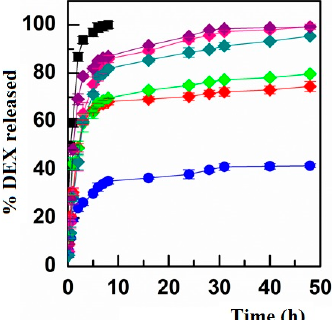
Figure 3. Drug release profiles: percentage of DEX released as a function of incubation time from INU-EDA-RA micelles (red), INU-EDA-RA-PEG micelles (green), INU-EDA-TAU-RA micelles (pink), INU-EDA-RA-CAR micelles (petrol green), and INU-EDA-RA-CRE micelles (violet) compared with the drug diffusion profile from DEX solution (black) and drug dissolution + diffusion profile from DEX suspension (blue). The values recorded when comparing the release behavior of the different micelles resulted in a statistically significant difference ( p < 0.05).